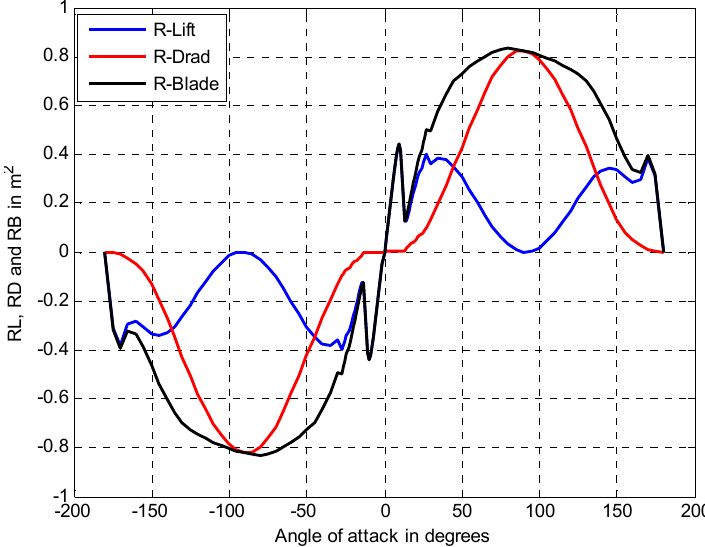
Figure 16. Lift, drag and normal resistance variations as functions of the angle of